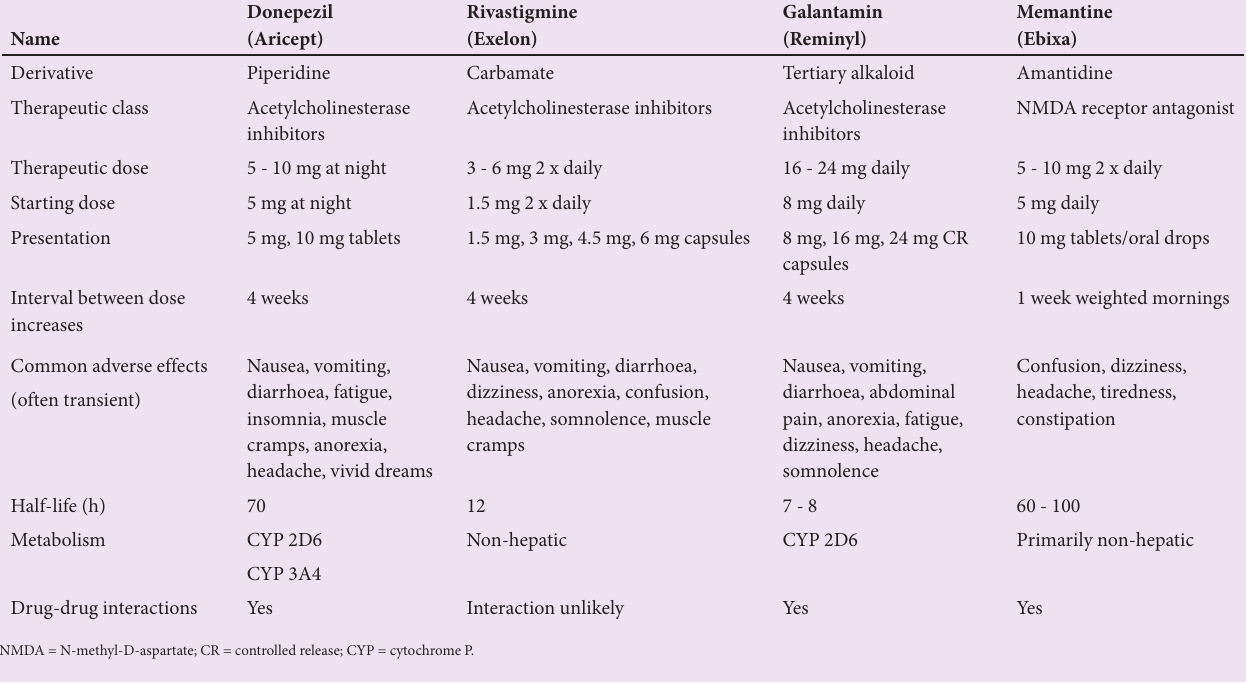
Table 3: Description of cognitive enhancers. Adapted from Taylo r et al. , [32] Ihl et al . [33] and Rossiter [34]